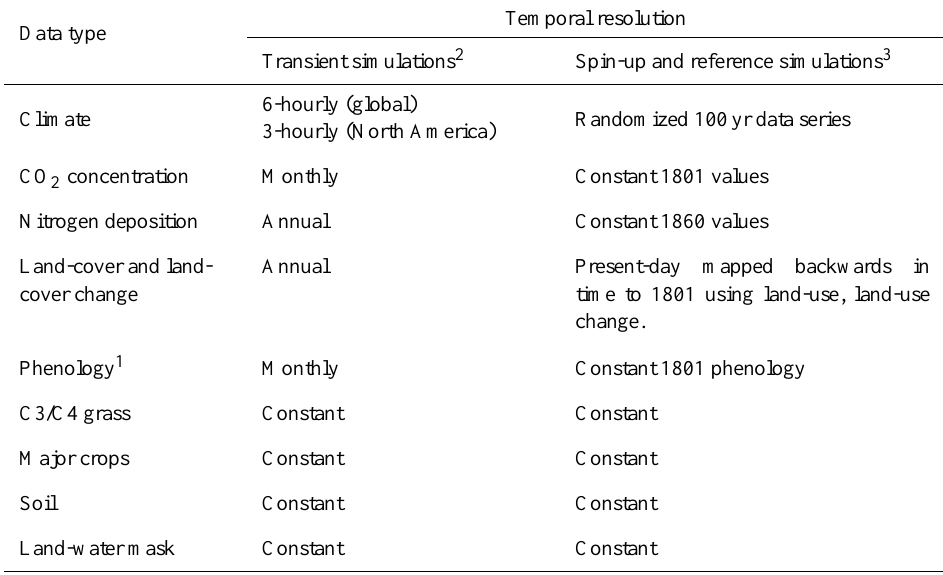
Table 1. Prescribed environmental driver data sets for MsTMIP